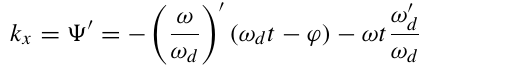
Fig. 5. Polarization ellipses of the wave excited by the moving cloud at different time instants. Dashed lines represent the drifting source. The bold line corresponds to k x = 0 (purely poloidal polar- ization of the wave). The right and left parts of the figure correspond to electrons and ions, respectively. Thin lines represent the lines of constant